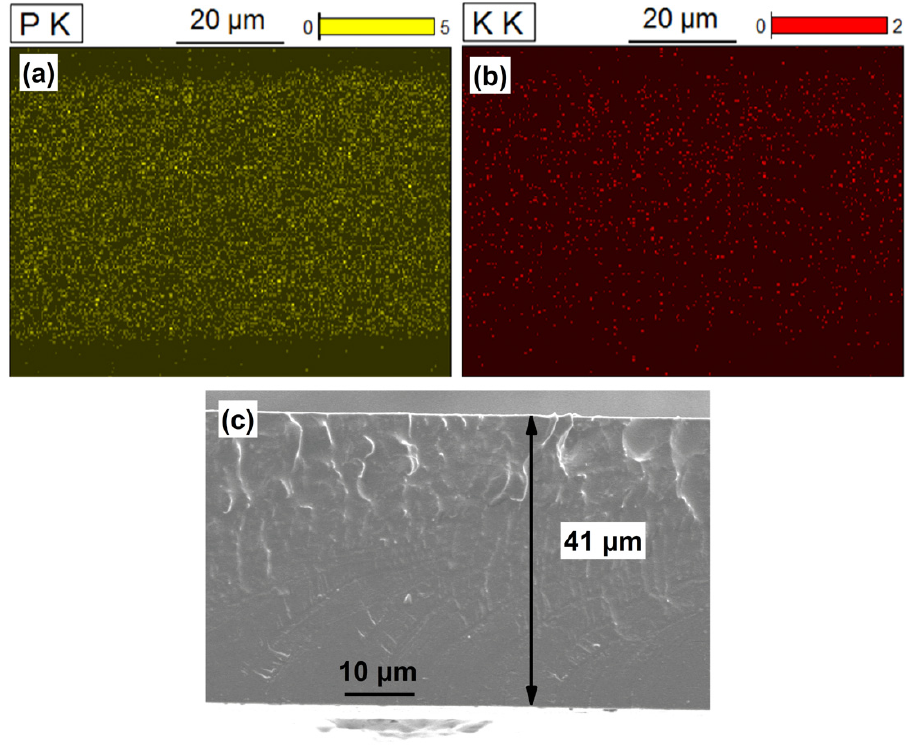
Figure 2. EDS mapping of ( a ) phosphorus and ( b ) potassium elements on the cross-section of KH 5 (PO 4 ) 2 -doped PBI membrane. ( c ) The cross-sectional morphology of KH 5 (PO 4 ) 2 -doped PBI